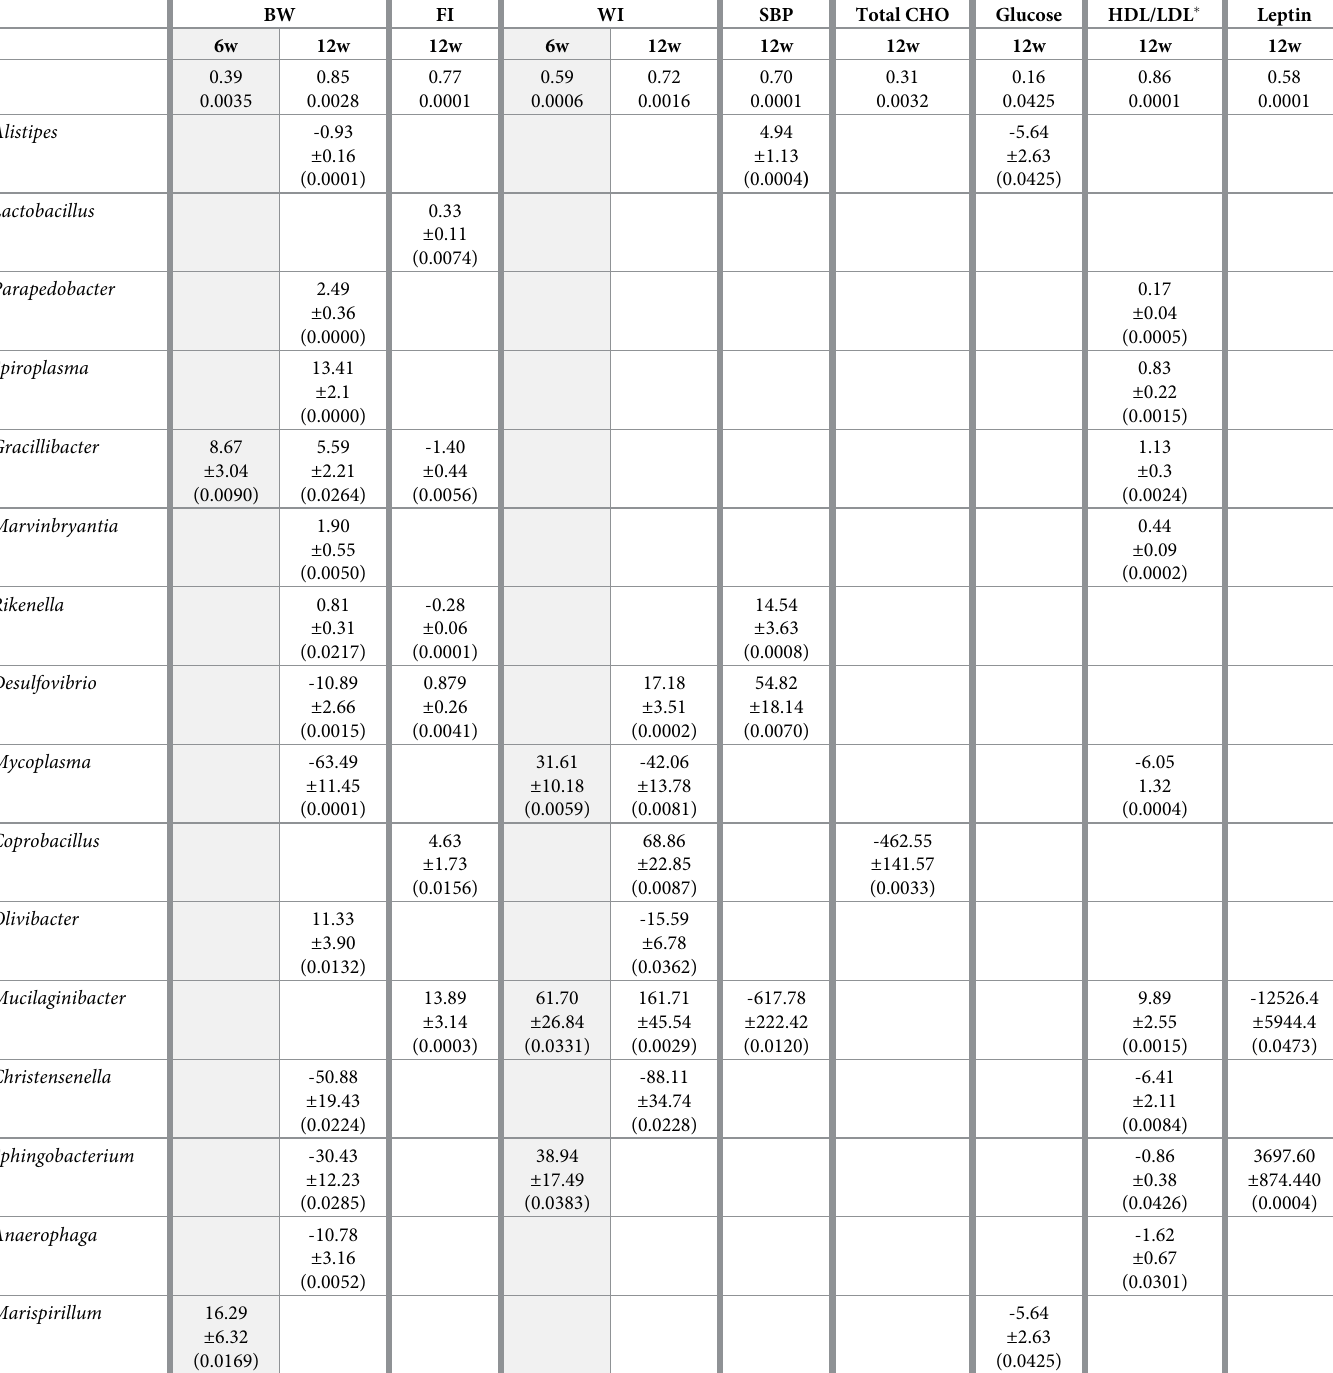
Table 4. Regression fits for each of the physiological variables studied using as independent variables those genera that show statistical differences in the percentage of sequences retrieved from faecal